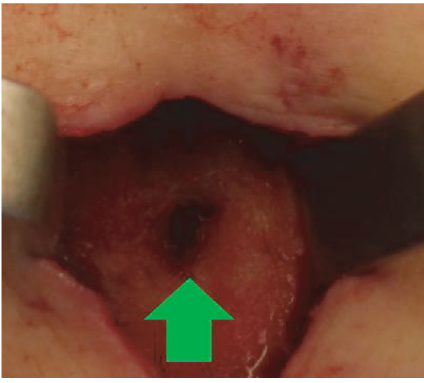
Figure 3: After draining the purulent collection, a hole of the 7th ribs was visualized (green arrow).